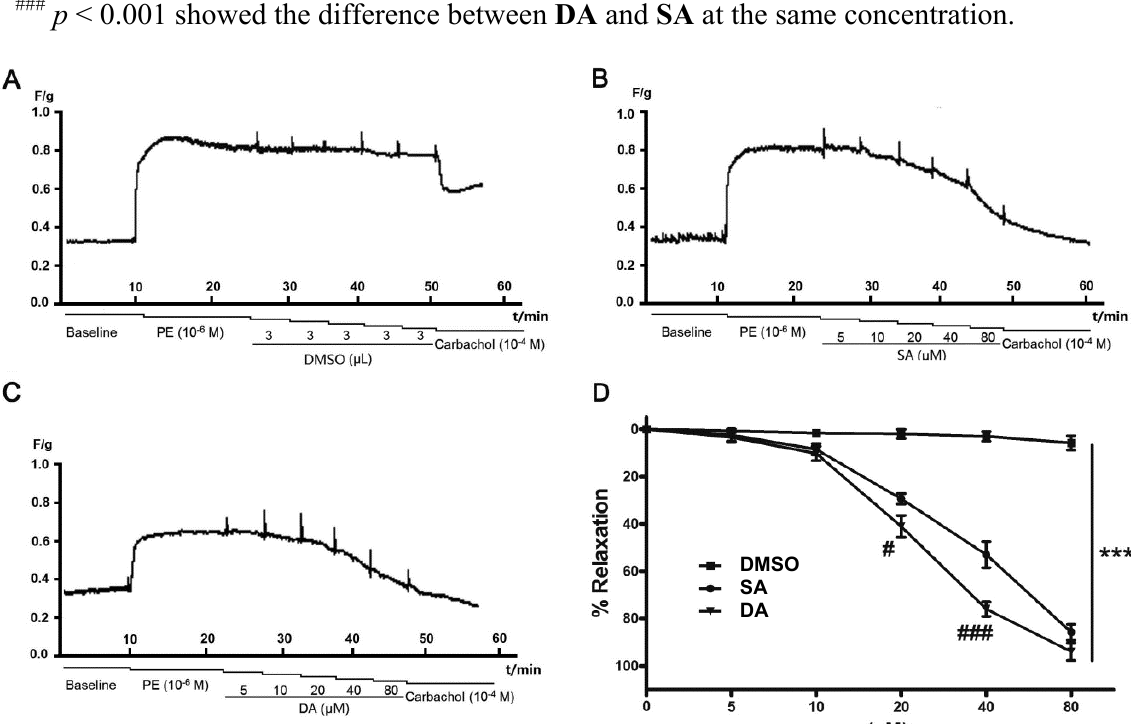
Figure 3. Effect of DA and SA on rats pulmonary artery rings precontracted with